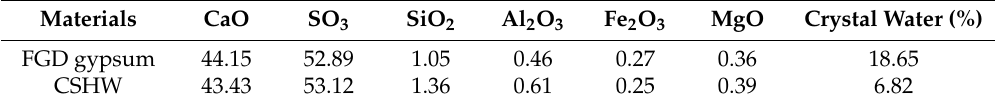
Table 2. Chemical compositions of FGD gypsum and CSHW (wt.